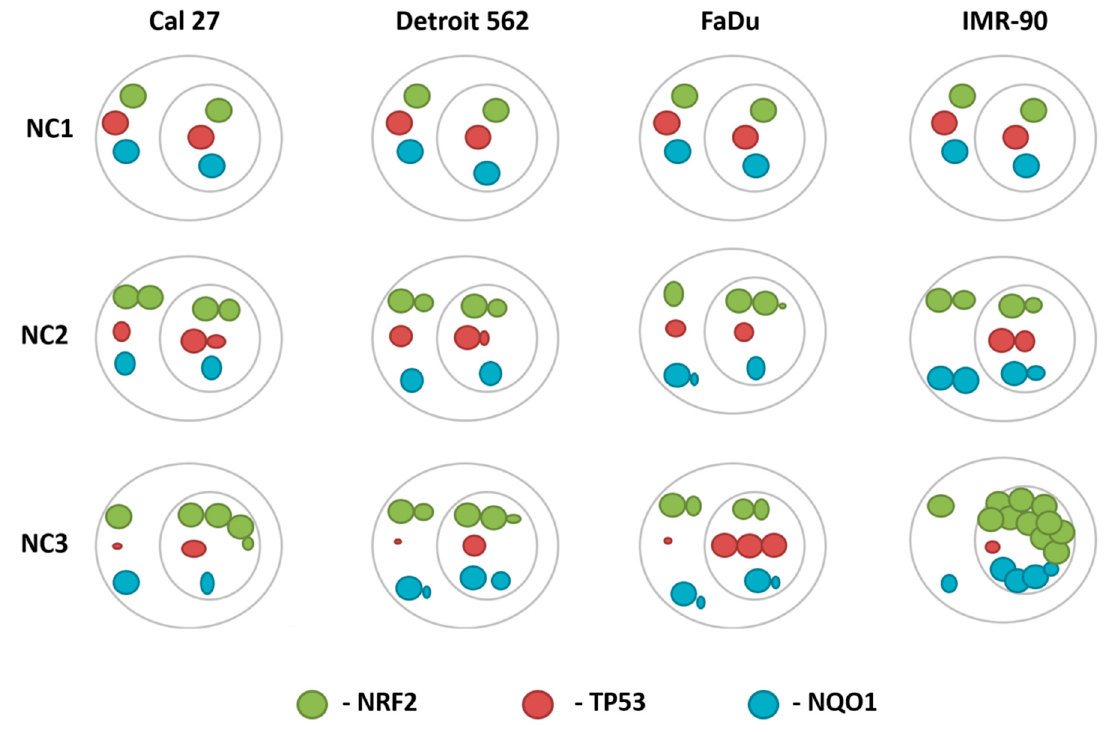
Figure 11. The cellular distribution and the rate of change of the NRF2, NQO1 and TP53 proteins in all four cell lines, under NC1-NC3.